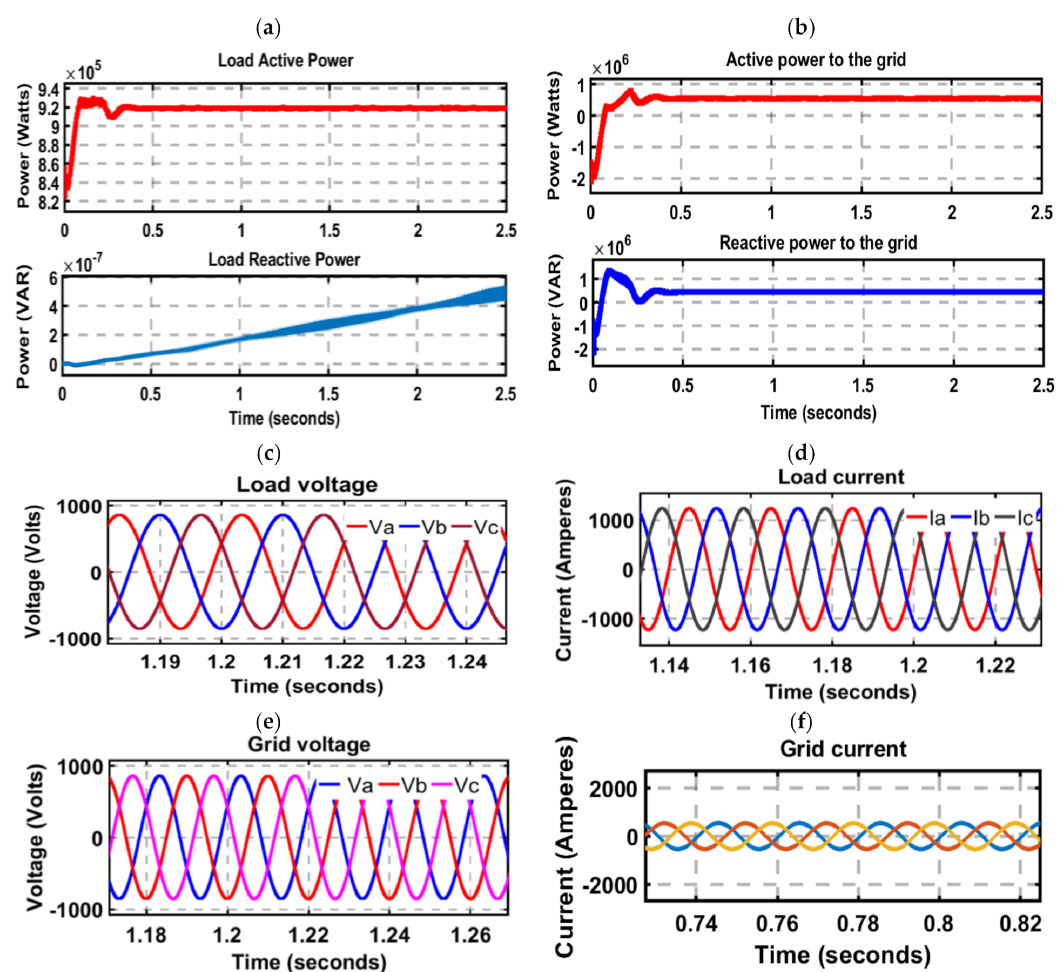
Figure 10. ( a ) Load active and reactive power, ( b ) grid active and reactive power, ( c ) load voltage, ( d ) load current, ( e ) grid voltage, and ( f ) grid